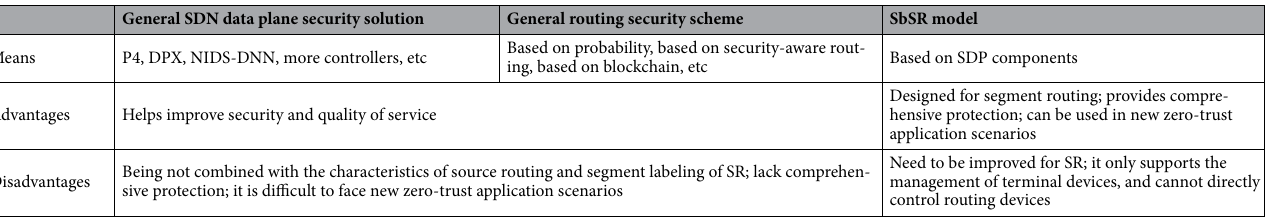
Table 2. Comparison of 3 types of security solutions.